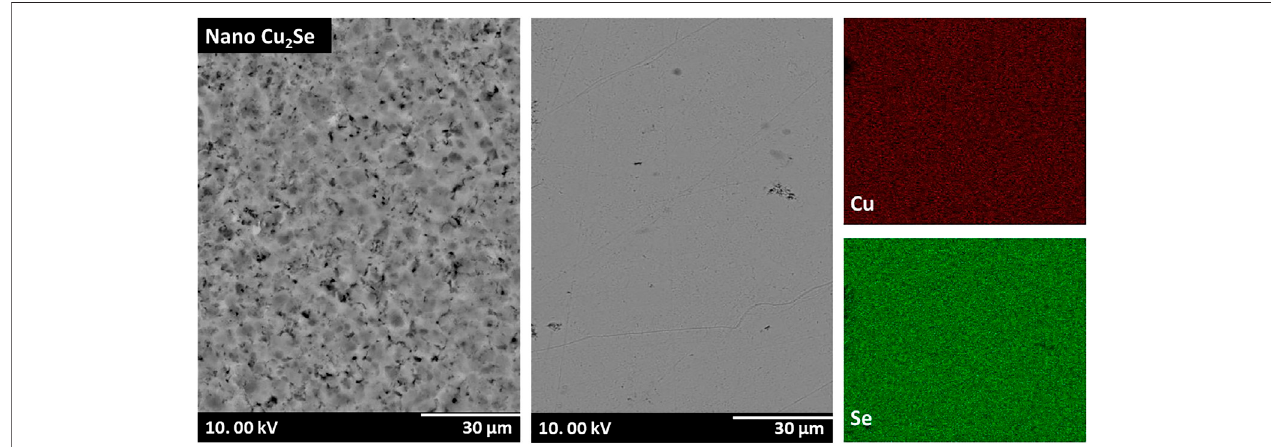
FIGURE 3 | Surface SEM-BSE micrographs and elemental mapping of nano-Cu